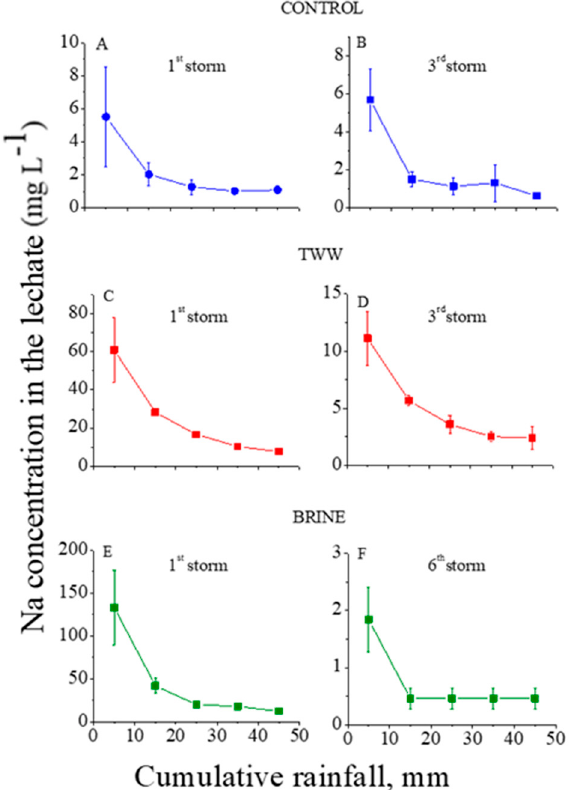
Figure 2. Na + concentrations in the outflow leachate from the trays with treated granular materials as functions of the cumulative rainfall of the 1st ( A ) and 3rd ( B ) consecutive rainstorms for the control, of the 1st ( C ) and 3rd ( D ) consecutive rainstorms for the treated wastewater (TWW) treatments, and of the 1st ( E ) and 6th ( F ) consecutive rainstorms for the brine treatment. Vertical lines near the symbols are standard deviations (the Y-axes’ scales are different).